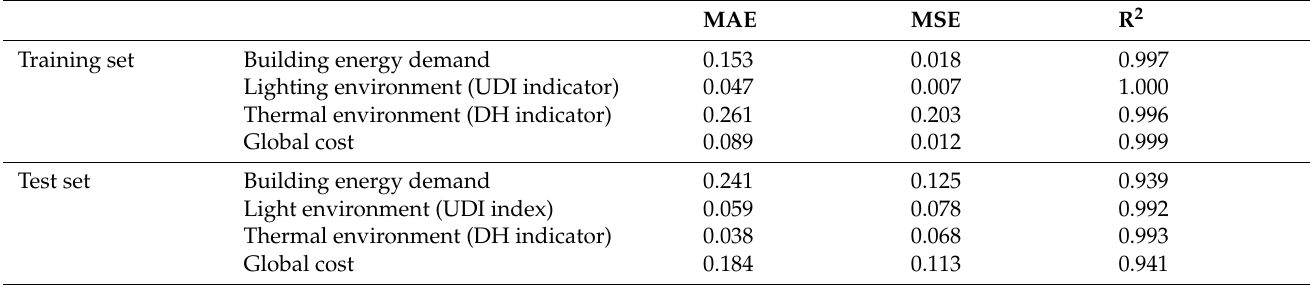
Table 7. Fitting degree of the neural network prediction